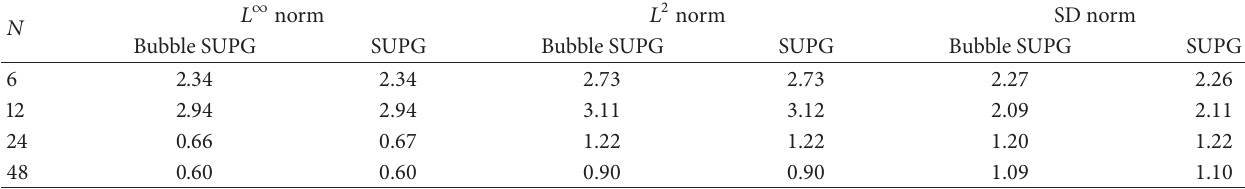
Table 9: 𝜀 = 10 −8 , Problem 3 (comparison of error).